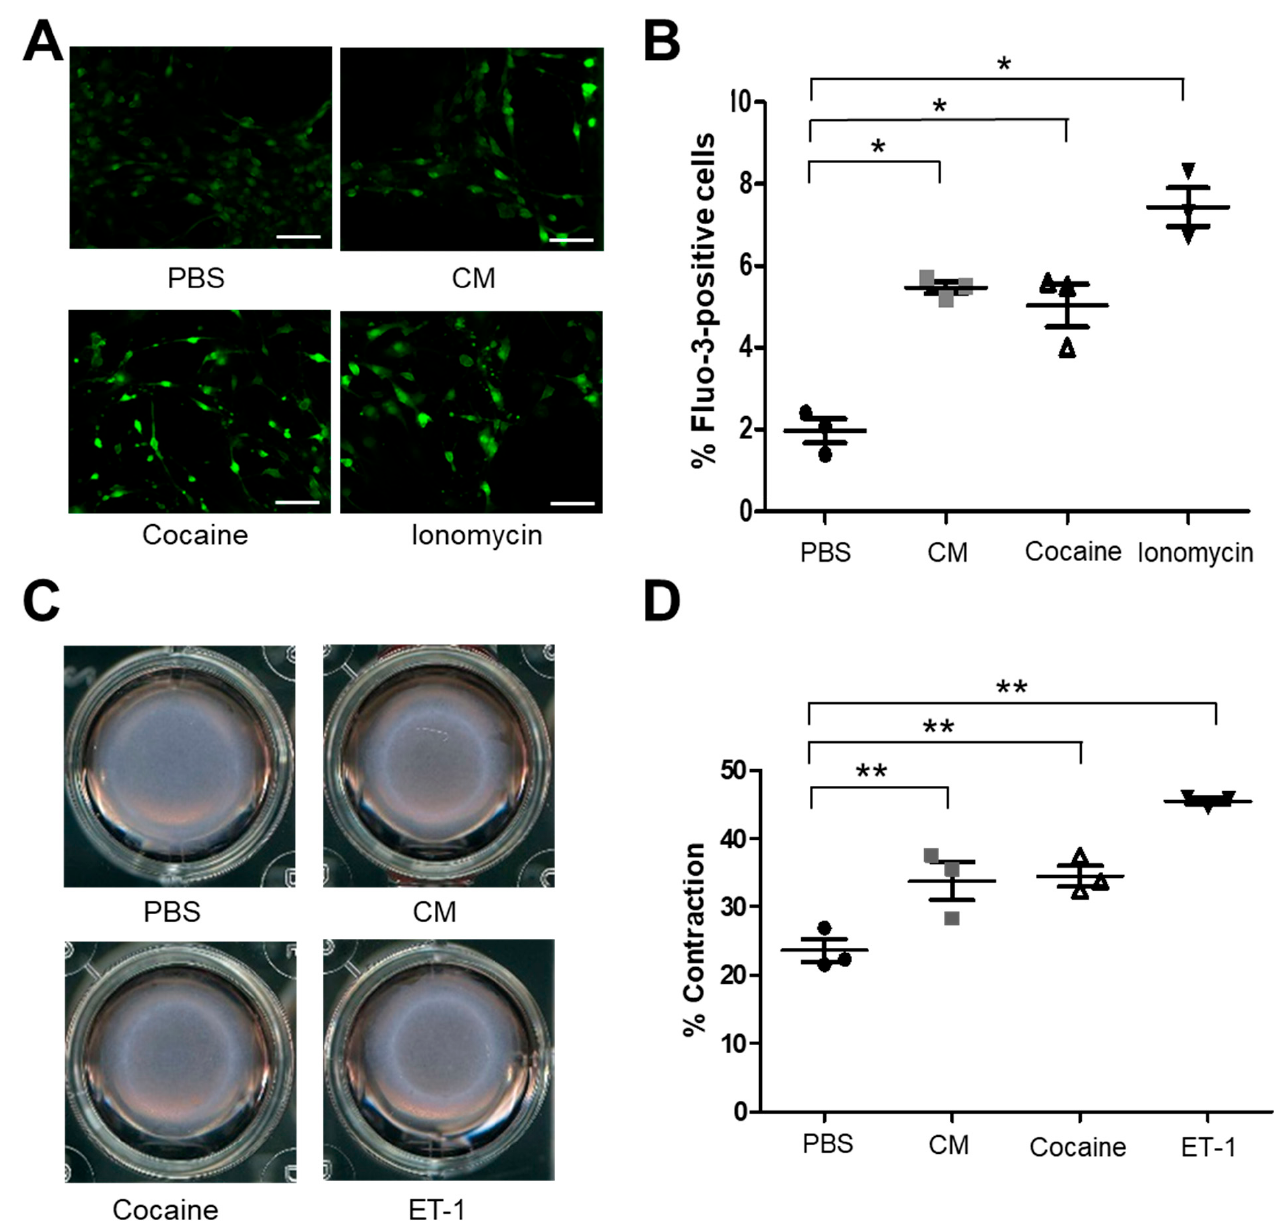
Figure 3. Cocaine and CM increase intracellular free calcium [Ca 2+ ] and induce primary mouse aortic SMC contraction. ( A ) Fluorescence image analysis of free cytosolic Ca 2+ in mouse aortic SMCs treated with PBS, CM, cocaine, or the calcium ionophore ionomycin (positive control) and stained with the calcium specific dye Fluo-3 AM show that cocaine and CM increase the level of intracellular free calcium in SMCs. Scale bars = 400 µ m. ( B ) Quantification by Image J software analysis fluorescence positive cells. Black circles = saline treatment, gray squares = CM treatment, open triangles = cocaine treatment, closed triangles = Ionomycin treatment (* p < 0.05 vs. saline). ( C ) Mouse Aortic SMCs were exposed to saline, cocaine, CM or the vasoactive peptide ET-1 (positive control), and their contractility was measured using the collagen gel contraction assay. Representative images of SMC contractility in the collagen contraction assay show increased SMC contraction in response to cocaine and CM. ( D ) Quanti fi cation of collagen gel contraction show both cocaine and CM substantially increase SMC contraction relative to PBS Student’s two tailed t -test was used for all statistical analysis (** p < 0.05 vs. PBS). Black circles = saline treatment, gray squares = CM treatment, open triangles = cocaine treatment, closed triangles = Endothelin-1 treatment.